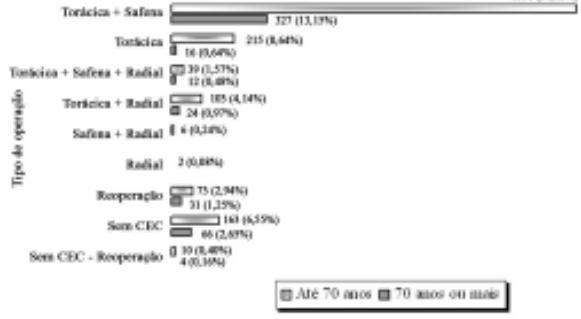
Fig. 1 – Tipo de operação x faixa etária, de agosto de 1994 a dezembro de